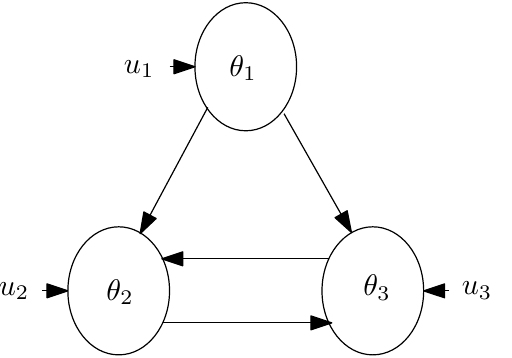
Figure 5. Topology of the interconnection of the bipedal robot locomotion system.